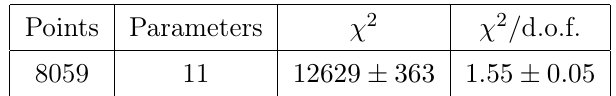
Table 5 . Total number of points analyzed, number of free parameters and (cid:31) 2